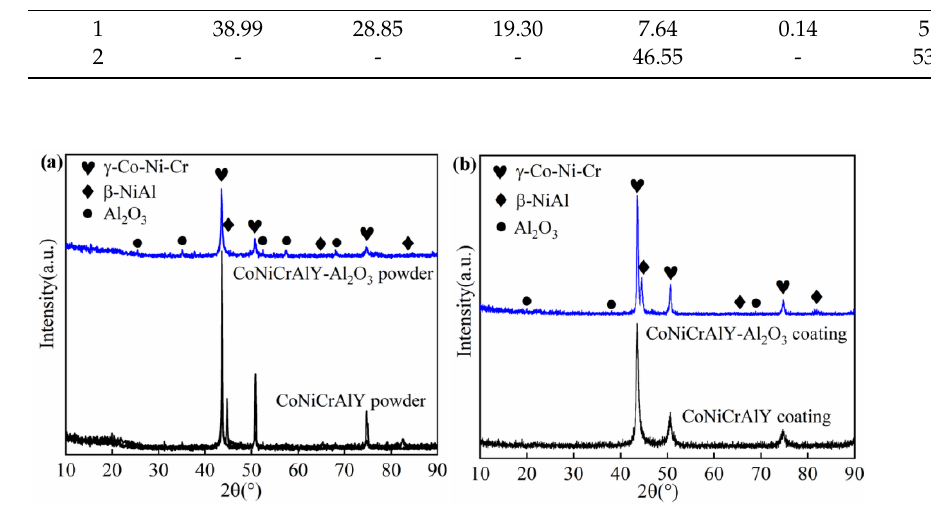
Figure 2. XRD patterns of powders ( a ) and these HVOF sprayed coatings ( b ) [25]. As shown in Figure 2b, the CoNiCrAlY coating is mainly composed of γ (Co, Ni, Cr) phase, and there is almost no β phase. This may be due to the consumption of β -NiAl phase due to the oxidation of the powder during the spraying process [30]. In addition, the β -NiAl phase may be redissolved in the γ (Co, Ni, Cr) matrix in the molten CoNiCrAlY droplets. Due to the high cooling rate during the thermal spraying process, the β -NiAl phase does not have enough time to reprecipitate in the γ (Co, Ni, Cr) matrix [31]. However, the significant difference is that the CoNiCrAlY-Al 2 O 3 composite coating prepared with the core-shell structured powder is composed of γ (Co,Ni,Cr) phase, Al 2 O 3 phase, and β -NiAl phase. Except for Al 2 O 3 , the phase structure of the coating is highly consistent with that of the CoNiCrAlY powder. The relative intensity of the diffraction peaks of the β -NiAl phase did not decrease significantly, indicating that the Al 2 O 3 shell significantly inhibited the oxidation behavior. In addition, the temperature changes of the droplets during the spraying process are also severely affected. 3.3. Microstructure of HVOF Sprayed Coatings Figure 3 illustrates the microstructure of HVOF CoNiCrAlY and CoNiCrAlY-Al 2 O 3 coatings. It is apparent that the microstructure of the CoNiCrAlY coating is uniform and compact, with a typical layered microstructure. During the spraying process, the oxide layer on the surface of the droplets is distributed in the form of oxide strips in the coating. The average thickness of the CoNiCrAlY coating is 388 μ m. The average porosity is about 1.6%, and the average oxide content is about 7.6%. There are few semi-melted particles and unmelted particles inside the coating. The bonding interface between the stainless steel substrate and the coating occludes each other, indicating a high bonding strength [32].